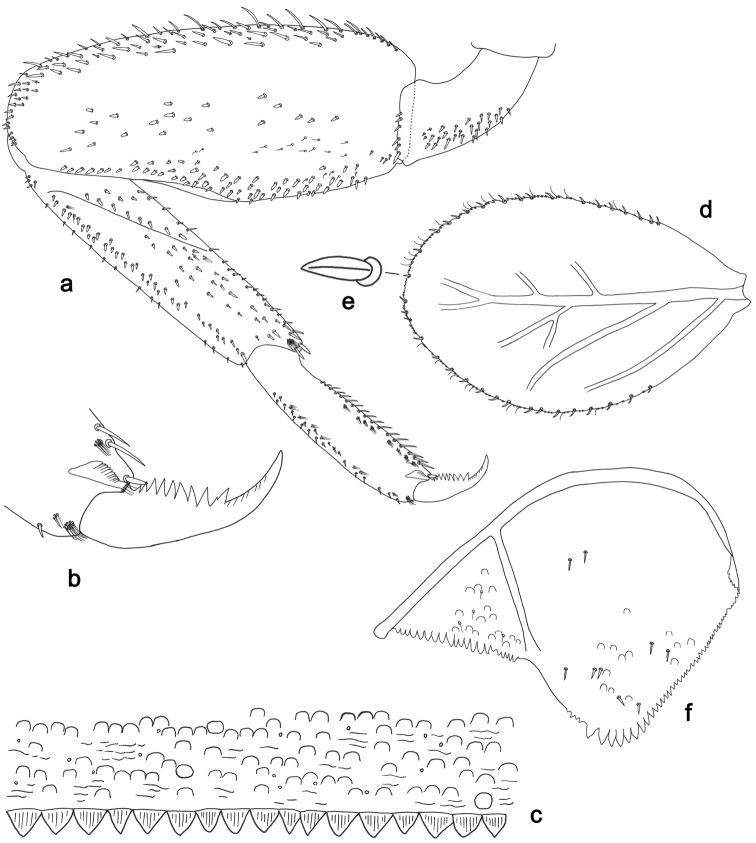
Labiobaetisbranchiaesetis sp. n., larva morphology: aForelegb Fore claw cTergum IV d Gill IV e Seta on gill margin fParaproct.